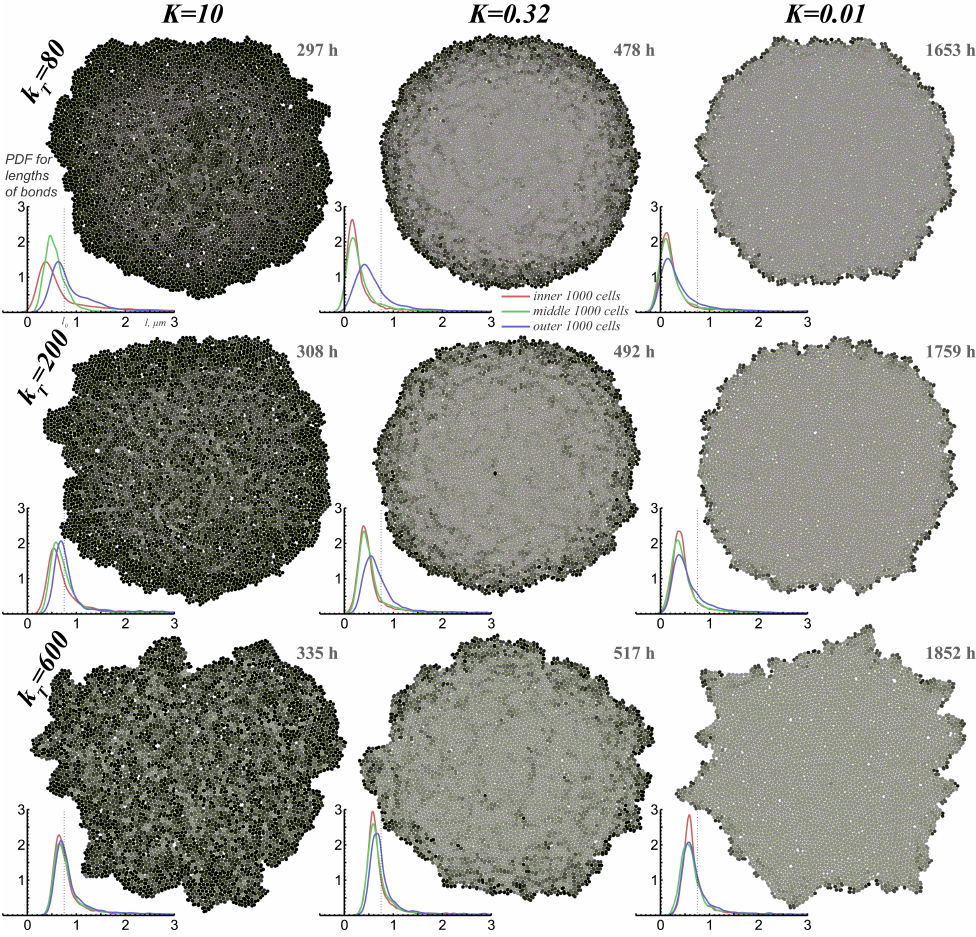
Figure 5. Tumors growing freely at the designated times when the number of cell pairs had just reached 3500, with the variation in the stress function coefficient k T and tissue conductivity K , along with the distributions of the bond lengths for inner (red lines), middle (green lines), and outer (blue lines) cells. The colors of the cells correspond to their speed of divergence v div , with lighter cells dividing more